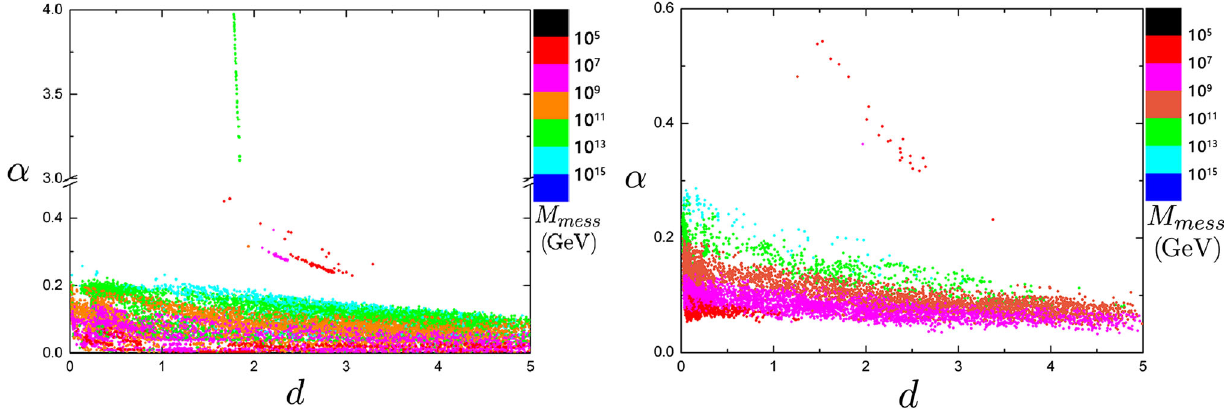
Fig. 3 The allowed regions for the deflection parameter ‘ d ’ versus α , which parametrize the relative size between the anomaly mediation and the modulus mediation. All samples satisfy the constraints (I–V)